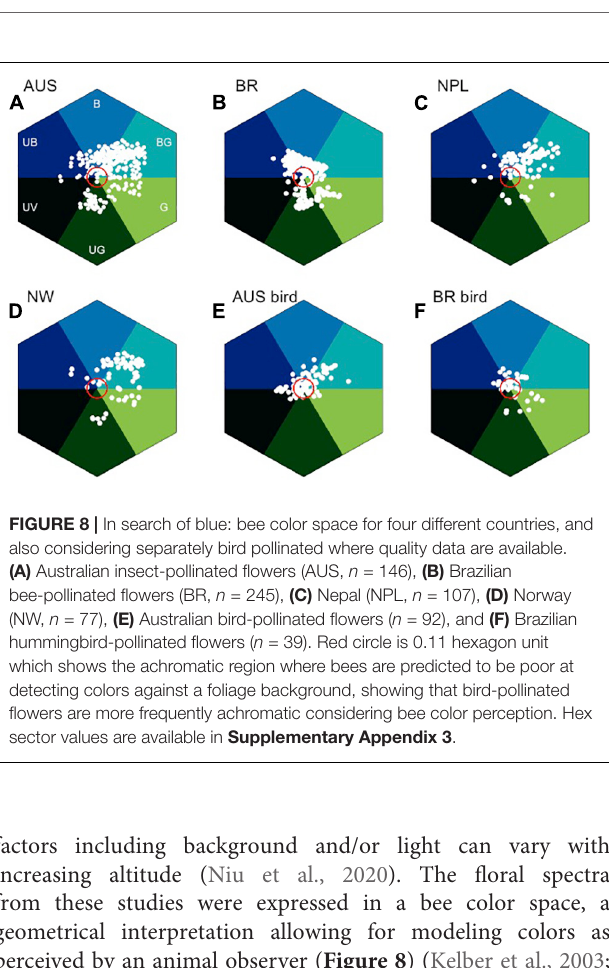
factors including background and/or light can vary with increasing altitude (Niu et al., 2020). The floral spectra from these studies were expressed in a bee color space, a geometrical interpretation allowing for modeling colors as perceived by an animal observer ( Figure 8 ) (Kelber et al., 2003;